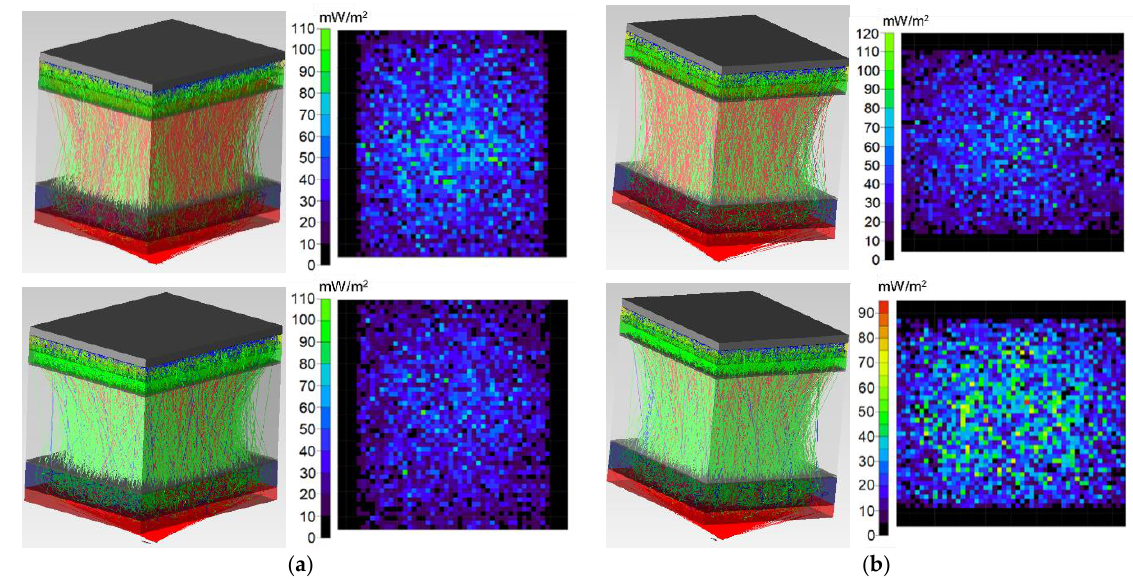
Figure 6. Simulation results for the probe radiation propagation through the maxillary sinus of female ( a ) and male ( b ) without pathology at a wavelength of 650 nm ( top ) and 850 nm ( bottom ).